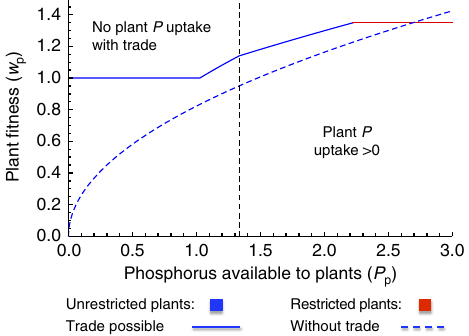
Figure 4 | Plant fitness with and without trade. The impact of trade on plant fitness changes with phosphorus available for direct uptake by plants ( P p ). When plants do not directly acquire any phosphorus, trade increases plant fitness (left of black dashed line). When plants acquire phosphorus but mycorrhizal fungi are not favoured to restrict, trade also increase plant fitness (solid blue line right of dashed black line). When fungi begin to restrict, the restriction cancels out any beneficial effects of increases in P p for plants (red line). Here, plants may be better off if they do not have trading partners. (In graph, n p ¼ 3, n f ¼ 3, C p ¼ 5, P f ¼ 2, a ¼ 0.5, b ¼ 0.5, e ¼